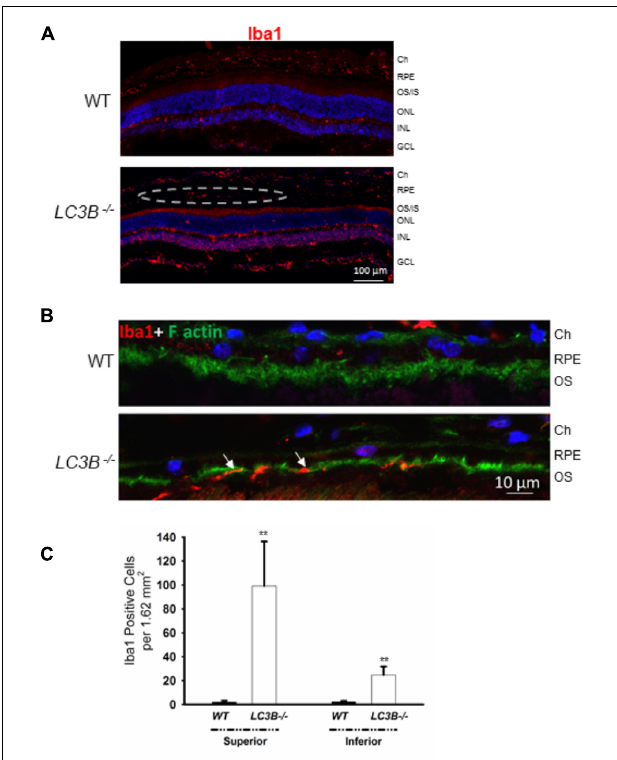
FIGURE 8 | Electroretinographic comparison of WT and L3CB − / − mice (age 14–20 months). (A) Representative dark-adapted ERGs obtained from a WT (left) and a L3CB − / − (right) mouse to strobe flash stimuli presented to the dark-adapted eye. Flash luminance (in log cd s/m 2 ) is indicated to the left of each pair of waveforms. (B) Amplitude of the major ERG components plotted against flash luminance. Data points indicate average ( ± SEM) of 7 mice. (C) Representative light-adapted ERGs obtained from a WT (left) and a L3CB − / − (right) mouse to strobe flash stimuli superimposed on a steady adapting field. Flash luminance (in log cd s/m 2 ) is indicated to the left of each pair of waveforms (D) Amplitude of the light-adapted ERG plotted against flash luminance. Data points indicate average ( ± SEM) of 7 mice. (E) Representative c-waves obtained from a WT (left) and a L3CB − / − (right) mouse to a 1.4 log cd s/m 2 flash presented to the dark-adapted eye. The c-wave peaks after the b-wave, and is reduced and delayed in L3CB − / − as compared to WT